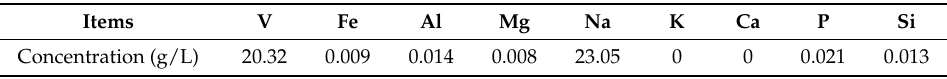
Figure 3. Proposed process flow sheet for preparation of stripped V (V) solution from vanadium- Figure 3. ProposedprocessflowsheetforpreparationofstrippedV(V)solutionfromvanadium-bearingshale. bearing shale. Table 4. Main chemical composition of the stripped V (V) Table 4. Main chemical composition of the stripped V (V) solution.